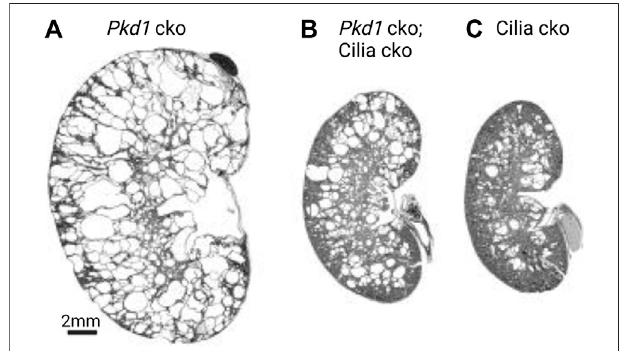
FIGURE 1 | Complex roles of cilia in cystogenesis. Cysts from PC1 loss are severe and only partially suppressed from cilia loss. Images adapted from (Ma et al., 2013) with permission. Postnatal day 24 (P24) kidneys from (A) Pkd1 cko ( Pkhd1-cre;Pkd1 fl / fl ) , (B) Pkd1 cko ; cilia cko ( Pkhd1-cre; Kif3a fl /- ;pkd1 fl / fl ) , and (C) cilia cko ( Pkhd1-cre;Kif3a fl /- ) mice. Abbreviations: cko, conditional